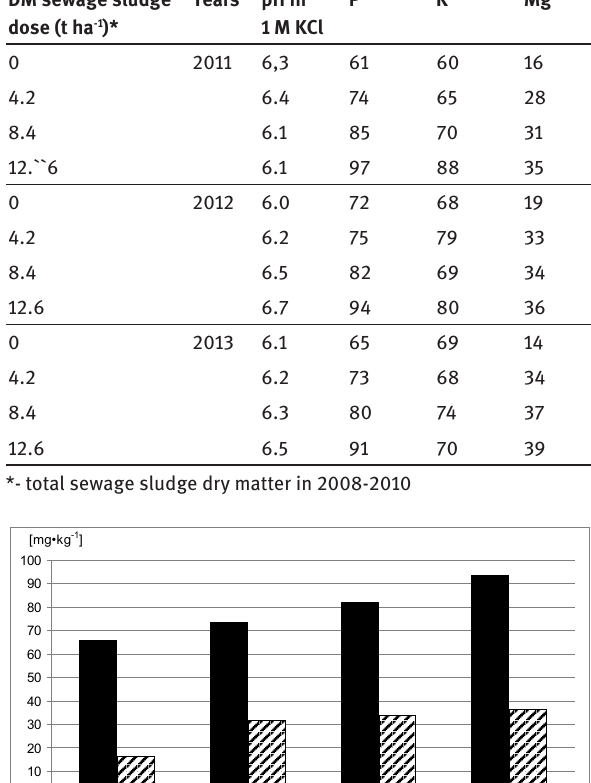
DM sewage sludge dose (t ha -1 )*